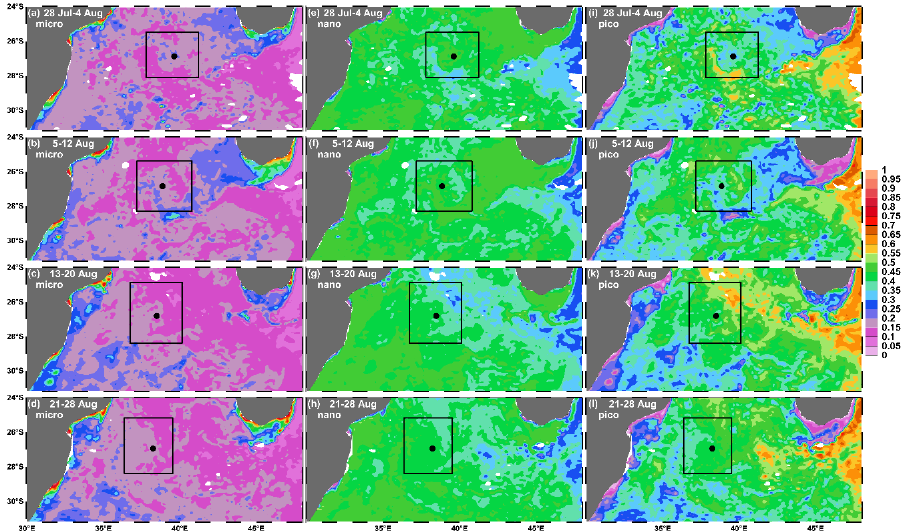
Figure 7. Fractional contribution of ( a – d ) micro-, ( e – h ) nano-, and ( i – l ) picophytoplankton to MODIS Aqua chlorophyll a for 28 July to 28 August 2013 over the Mozambique Basin. Black boxes highlight the location of the cyclonic eddy and black dots indicate the centre of the eddy. White areas indicate missing data due to cloud cover.